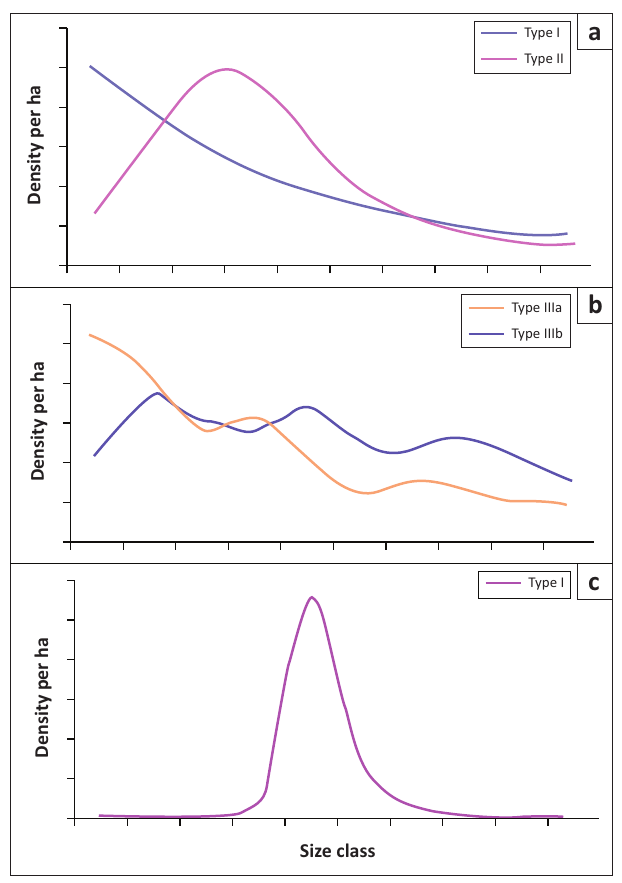
FIGURE 3: Idealised shapes of the four different population curve